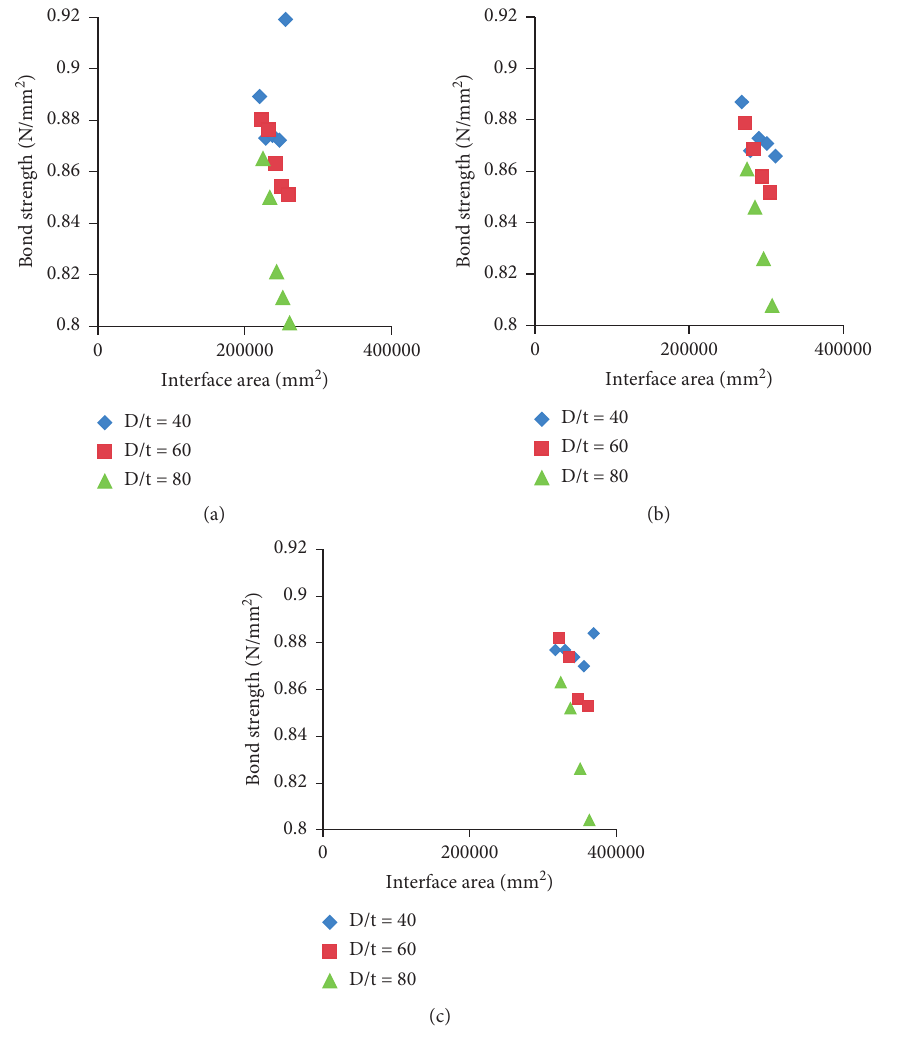
Figure 13: Variation in bond strength with Interface area. (a) Interface length 450 mm. (b) Interface length 550 mm. (c) Interface length 650 mm. Table 4: Comparison of bond strength of experimental specimens with proposed formula. Sl no.